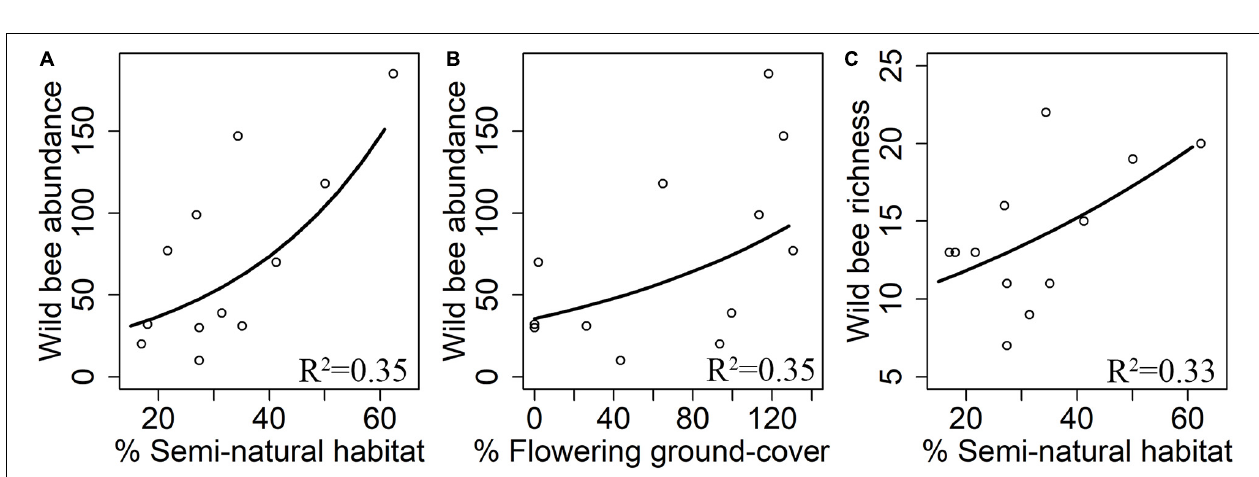
FIGURE 4 | Effects of flowering ground cover and landscape composition on abundance (A,B) and species richness (C) of wild bees. R 2 means adjusted R -squared of the final model.